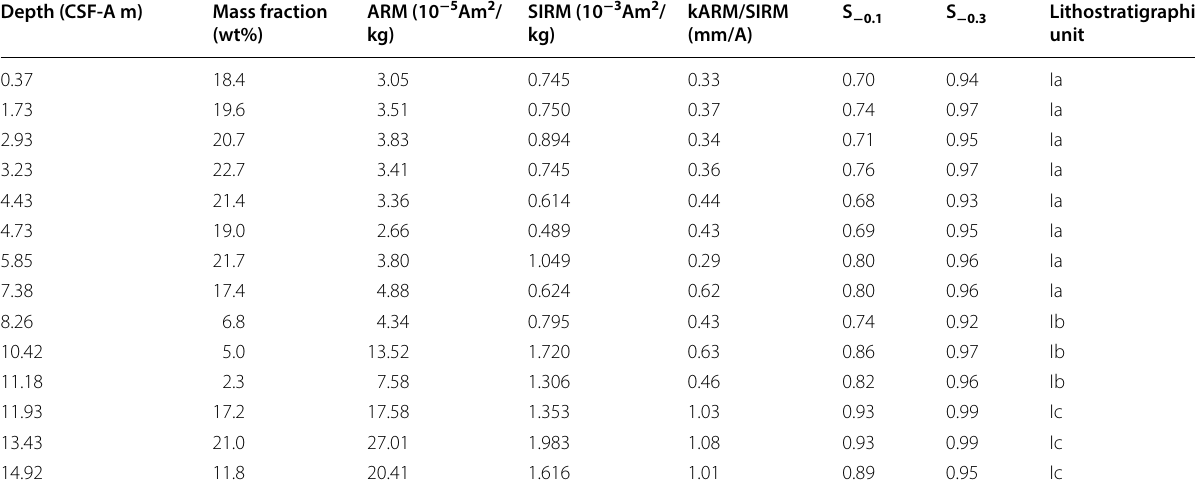
Table 1 Summary of the characteristics of quartz and feldspars Depth (CSF-A